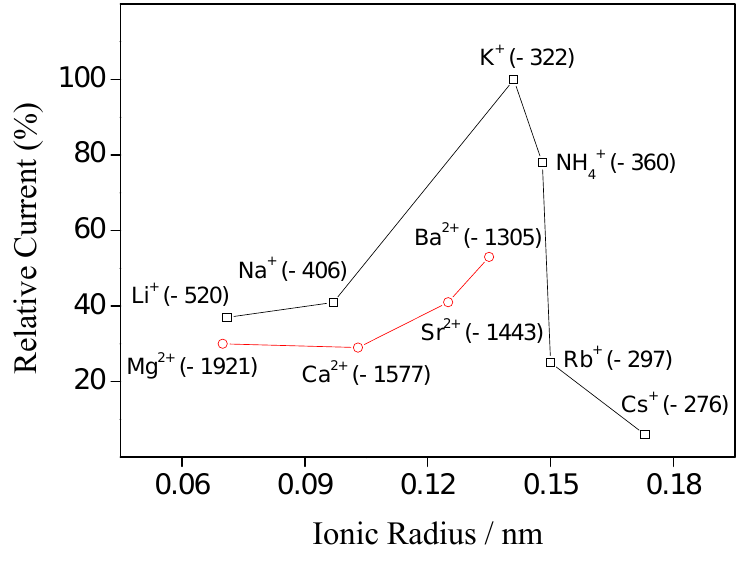
Figure 5. Plot of relative current of the sensor versus ionic radius of alkaline and alkaline- earth ions. The values in parentheses represent the dehydration energy (23) for each cation